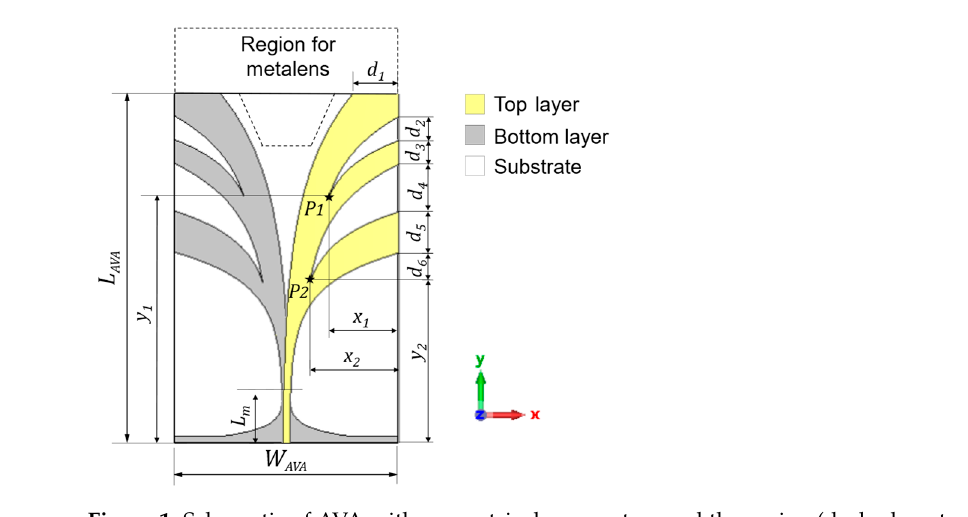
Figure 1. Schematic of AVA with geometrical parameters and the region (dashed contour) hosting the metalens. Table 1. Geometrical parameters of the AVA.